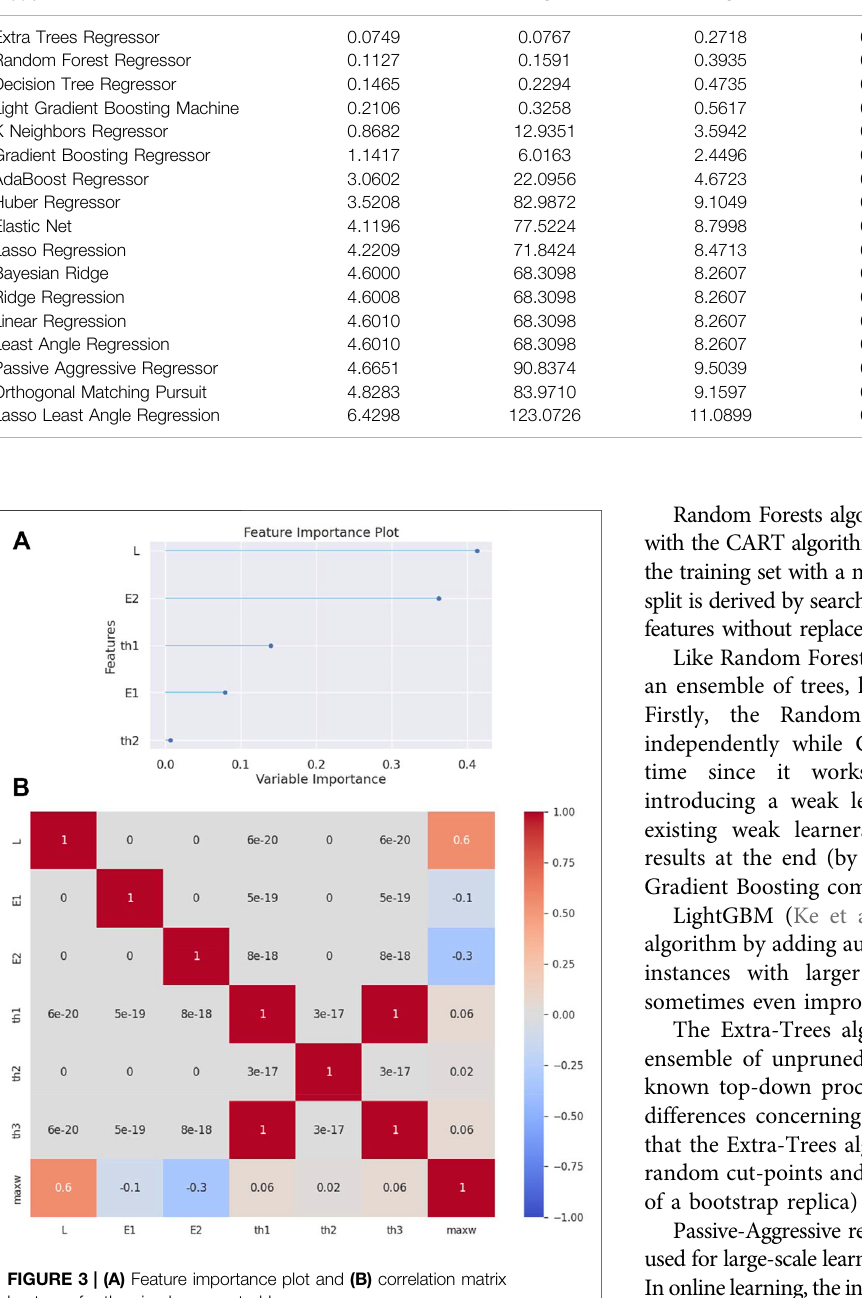
Frontiers in Built Environment |